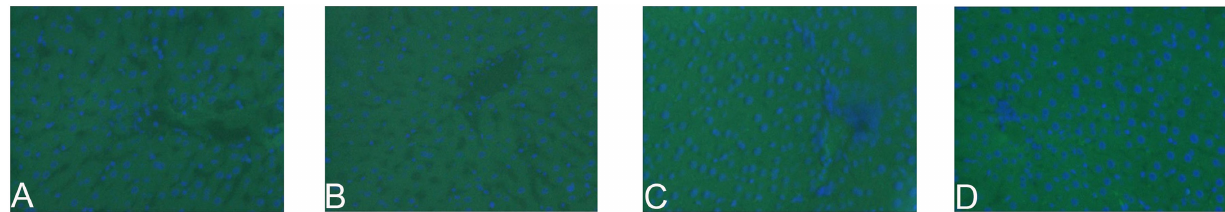
Figure 3. Representative micrographs from group I (A), group II (B), group III (C), and group IV (B) shows 8-hydroxy-2’-deoxyguanosine immune negativity. × 20 immunofluorescent